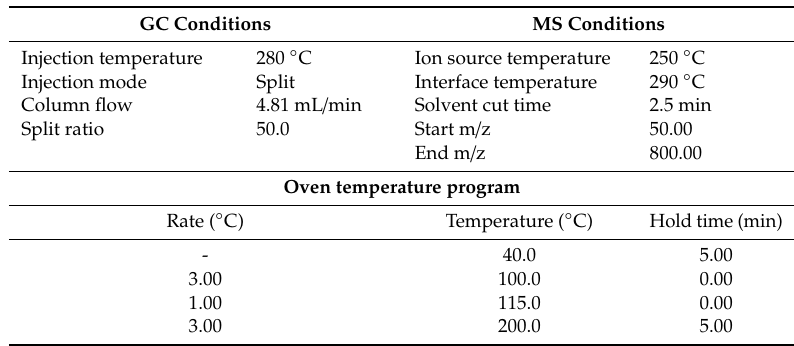
Table 4. Gas Chromatography-Mass Spectrometry